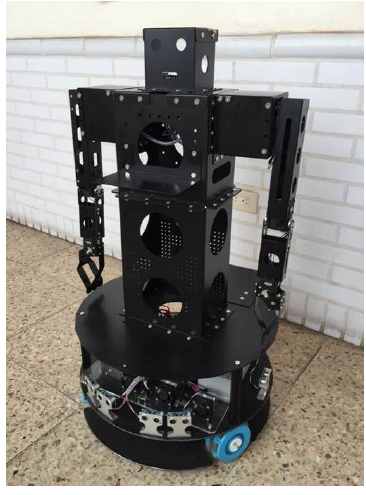
Figure 9. Omnidirectional WMR.